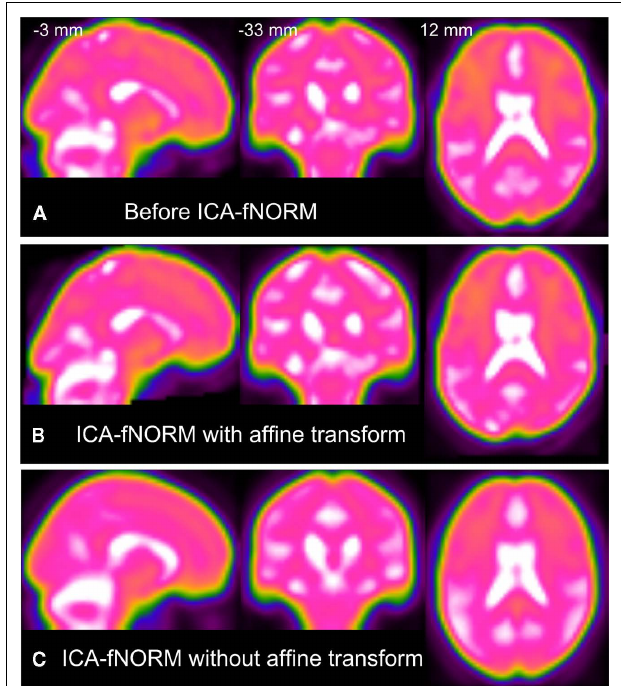
FIGURE 3 |A comparison showing global shape distortion effects due to affine transformation applied along with the functional normalization step: (A) Original image, (B) ICA-fNORM with second affine transform, (C) ICA-fNORM without second affine transform. We use a non-conventional color-scheme to better highlight the shape distortion effects. Images in (A–C) are derived from the same MNI co-ordinates mentioned in (A)